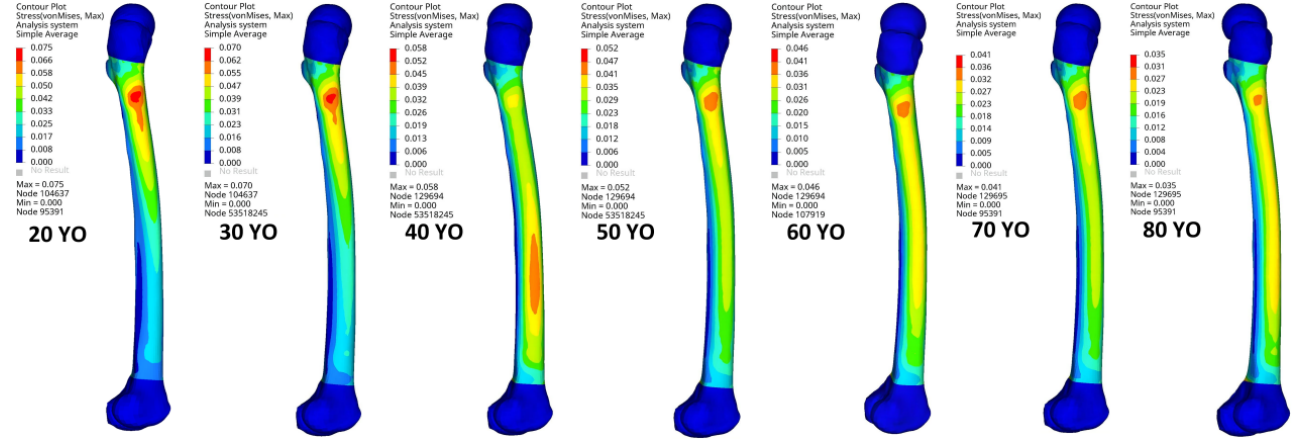
Figure 8. Comparison of the Von mises stress contours of the femur in seven ages at 40 km/h.